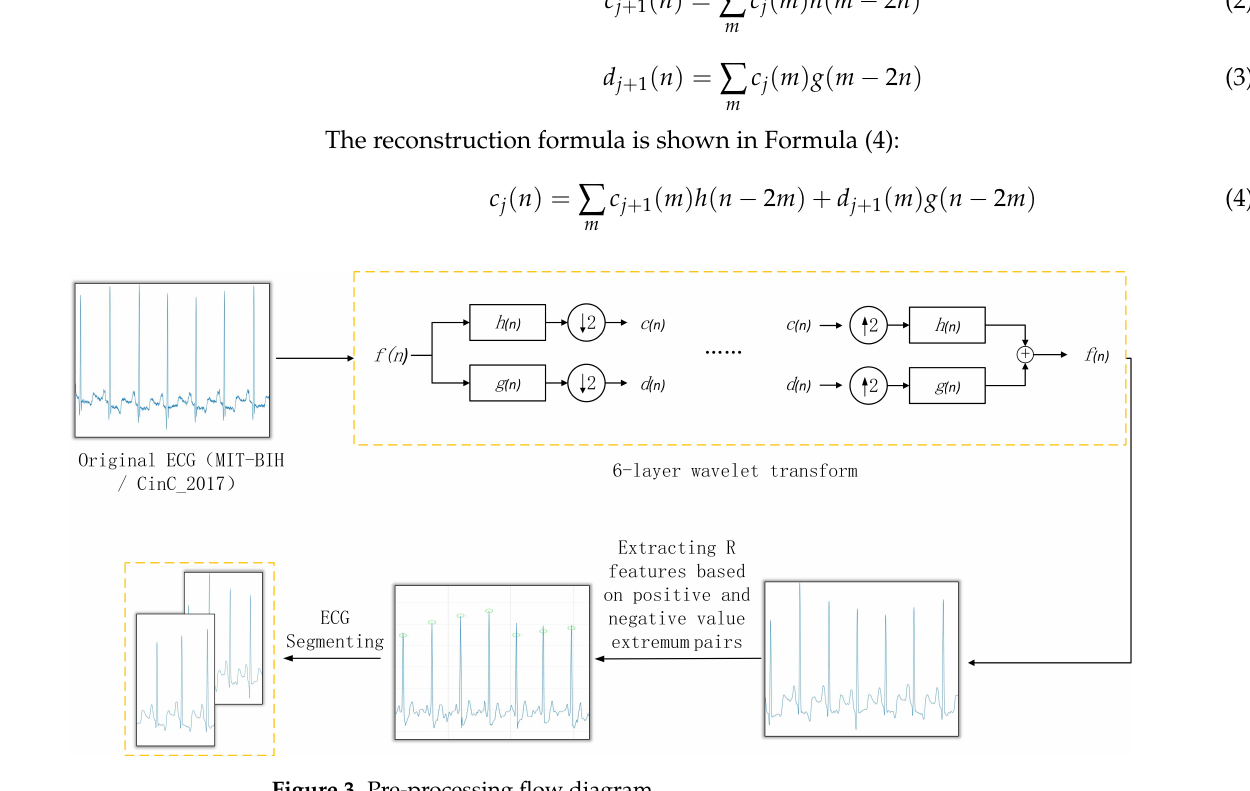
Figure 3. Pre-processing flow diagram.